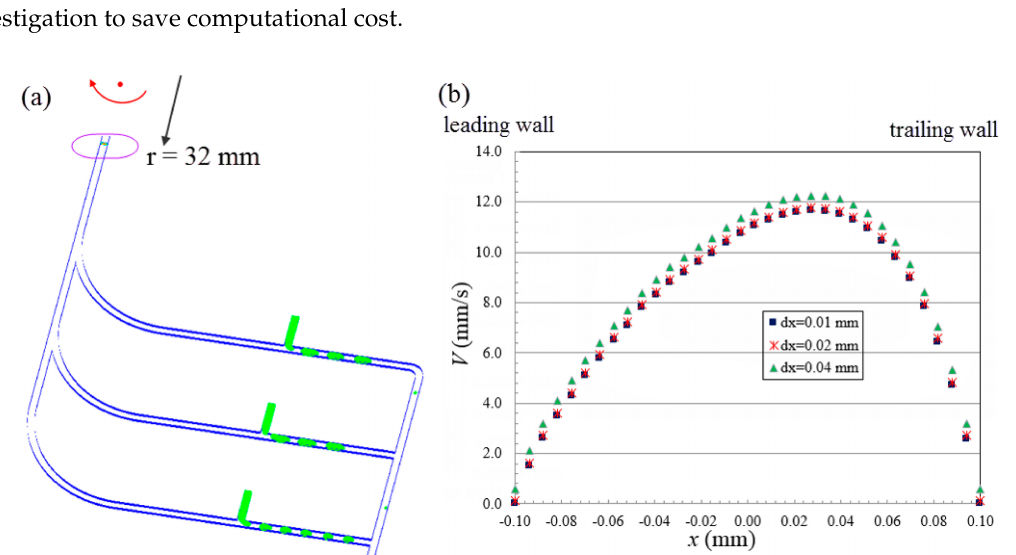
in Figure 3a. In the rotating reference frame of the channel, the centrifugal force, F cen , acting on the fluid drives the throughflow towards the outlet with a velocity of V ( x , y ), where x and y represent the coordinates along the width-wise and height-wise direction, respectively. The throughflow along the rotating channel induces a Coriolis force, F cor , which is directed normal to the throughflow, yet opposite to the rotation direction. The magnitude of the Coriolis force depends on the magnitude of throughflow, which is a parabolic profile with maximum velocity at the center of the channel and zero velocity at the channel walls due to no slip. The Coriolis force produces a crossflow at the mid-plane ( y = 0) of the channel directing towards the trailing wall ( x = W /2) with flow returning near the front wall ( y = H /2) and back wall ( y = ´ H /2) of the channel towards the leading wall ( x = ´ W /2). The crossflow continuously evolves as the fluid moves downstream. However, due to the Coriolis effect acting in the width-wise direction, the peak of the developing throughflow across the width of channel shifts towards the trailing wall ( x = W /2) and results in an asymmetric parabolic profile, as shown in Figure 3b. A mesh size sensitivity study was conducted to determine the optimal size of mesh grids. Given the velocity profiles corresponding to the two mesh sizes dx = 0.02 (coarser mesh) and 0.01 mm (finer mesh), respectively, are in agreement, the mesh size of 0.02 mm was adopted in the following investigation to save computational cost.